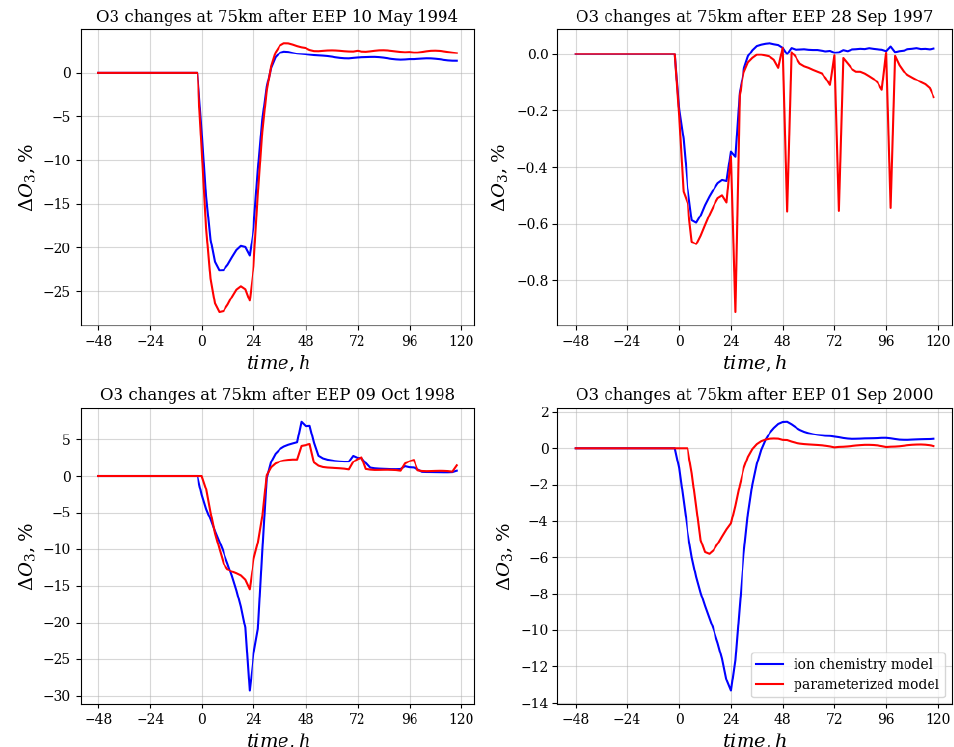
Figure 5. Simulation results of ozone change at 75 km. The 0 on the horizontal scale is midnight of the corresponding day.